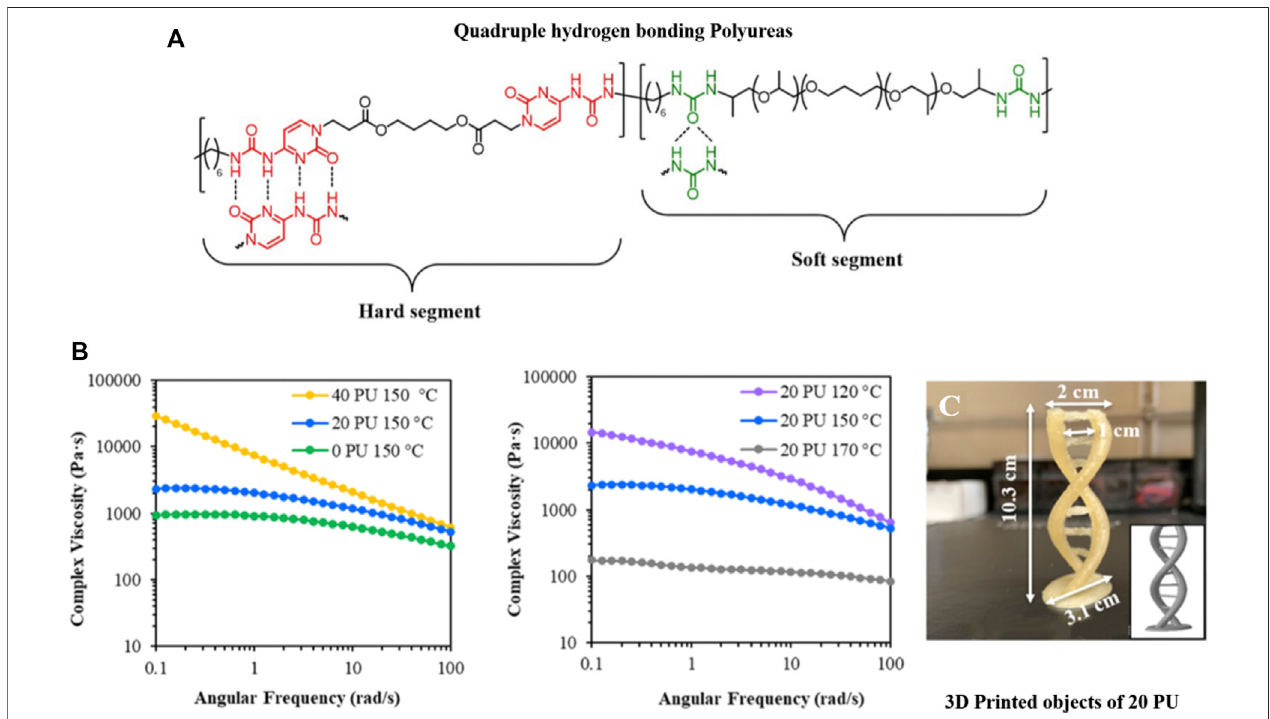
FIGURE 5 | FDM-printed polyureas with UPy groups inside the polymer backbone (A) . The supramolecular interaction increased viscosity due to hydrogen bonding-based crosslinking and phase separation of the functional groups (B) . The UPy-strengthened polyurea was used in FDM printing to design a double helix (C) . Reproduced with permission (Chen et al., 2020b). Copyright 2020, American Chemical